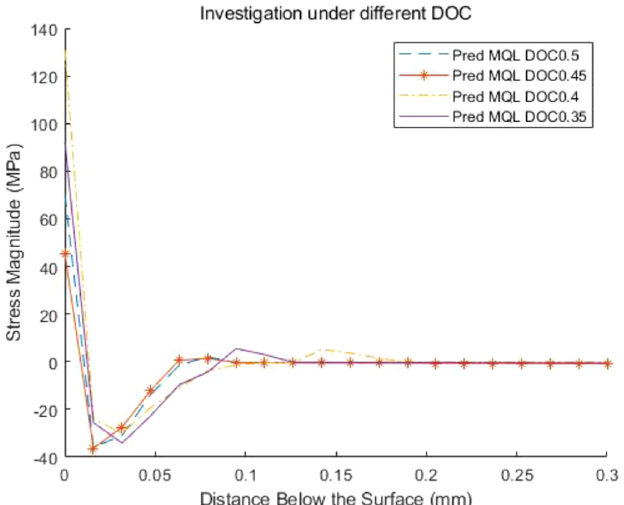
Fig. 11. Investigation of the residual stress under MQL with cutting velocity 1600m/min, feed per tooth 0.2 mm at different depth of